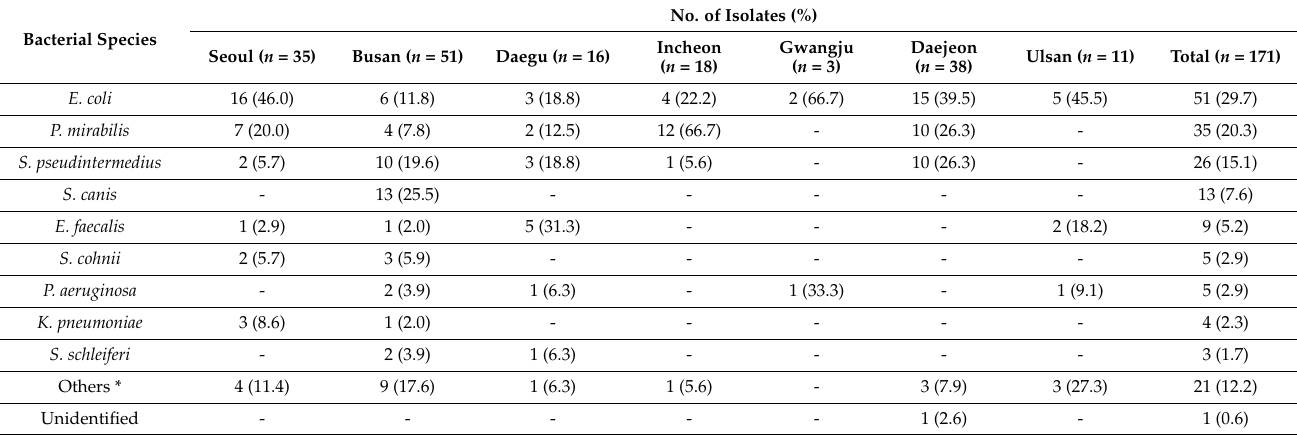
Table 4. Recovered isolate prevalence in urine samples of dogs during nationwide surveillance (2018–2019).